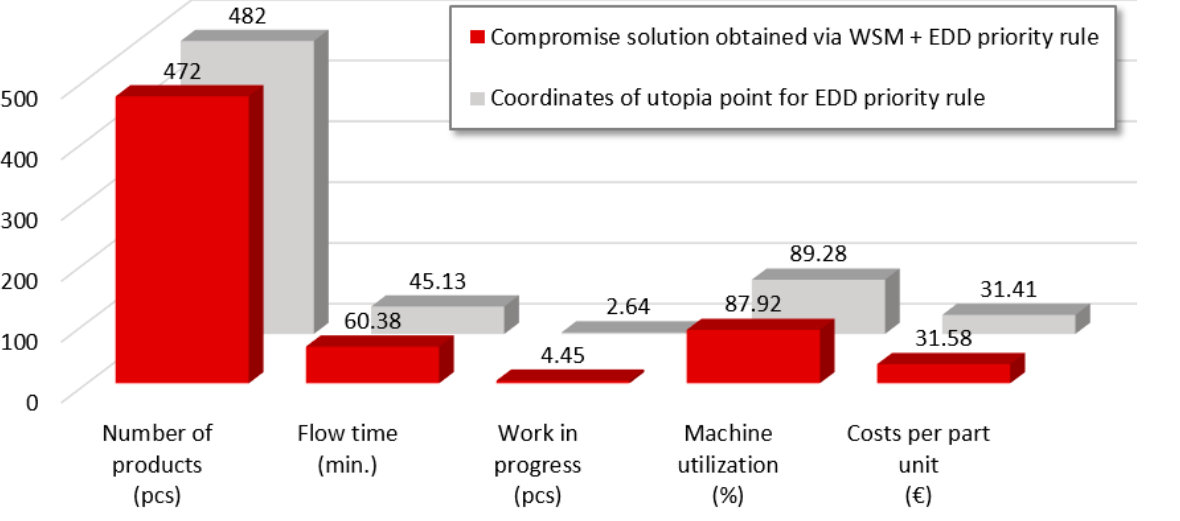
Figure 6. The comparison of coordinates of the ideal point for the EDD priority rule and solution yielded by WSM +